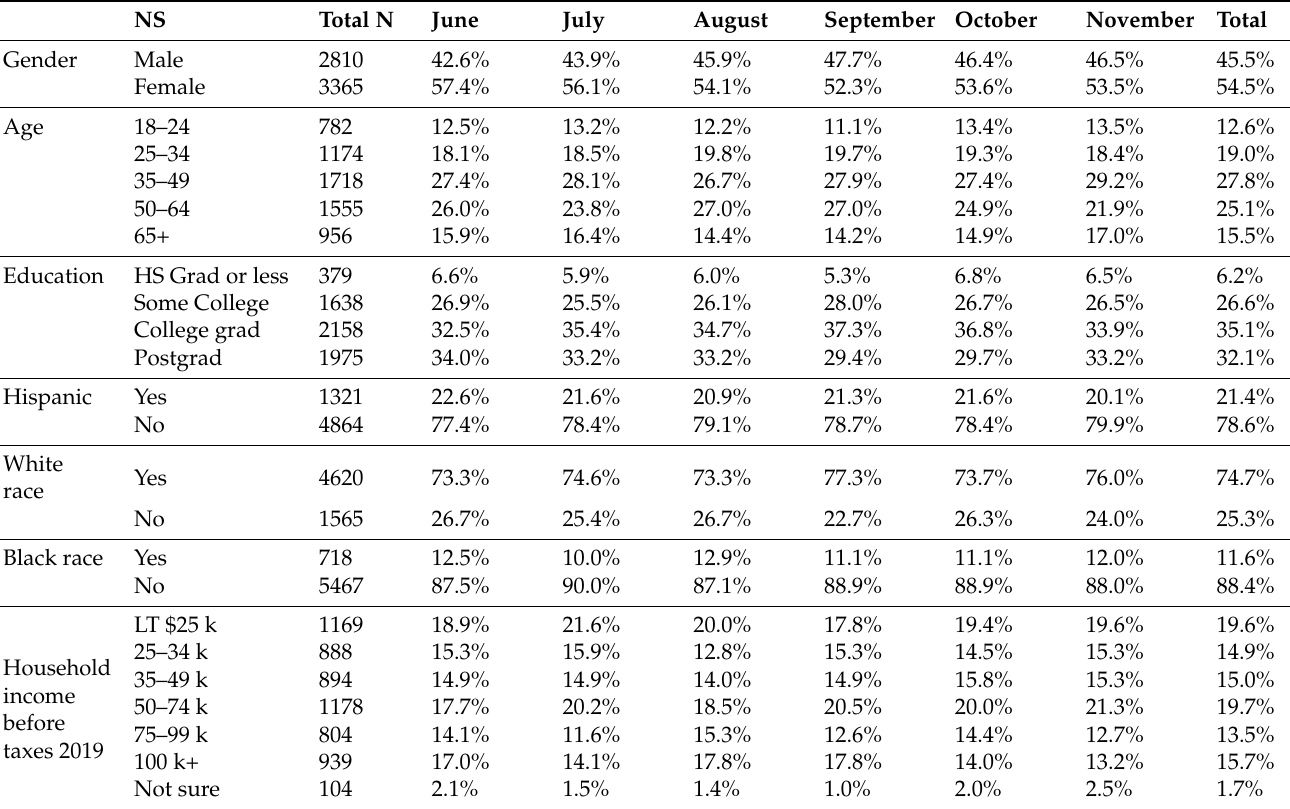
Table A1. Sample Demographics (Unweighted) by